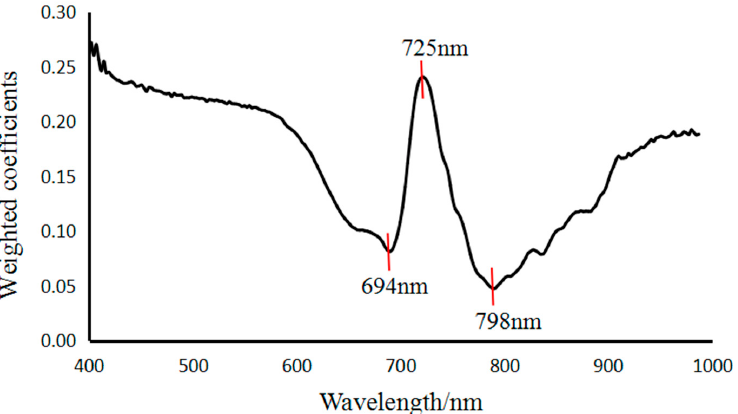
Figure 8. Weighted coefficient of PC3 image.